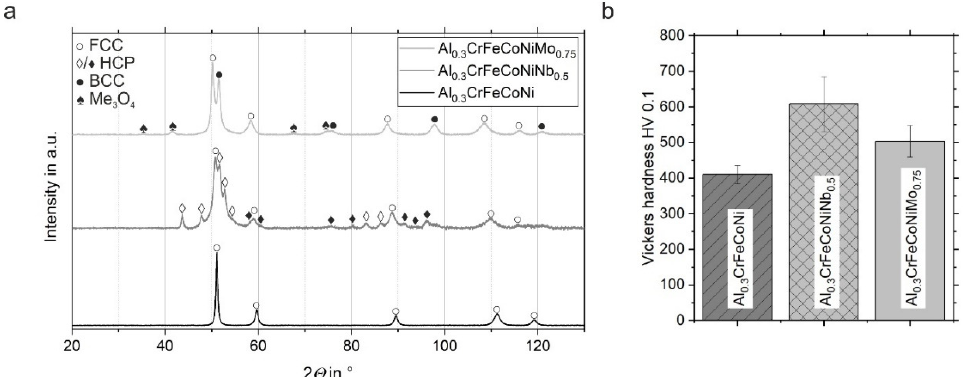
Figure 3. ( a ) XRD diffractogram and ( b ) Vickers hardness HV 0.1 of HVOF-sprayed coatings of Al 0.3 CrFeCoNi, Al 0.3 CrFeCoNiNb 0.5 , and Al 0.3 CrFeCoNiMo 0.75 . The higher hardness of HVOF- sprayed Al 0.3 CrFeCoNiNb 0.5 and Al 0.3 CrFeCoNiMo 0.75 results from additionally formed phases (HCP, Me 3 O 4 ) in comparison to the lower hardness of the single-phase Al 0.3 CrFeCoNi HVOF coat-